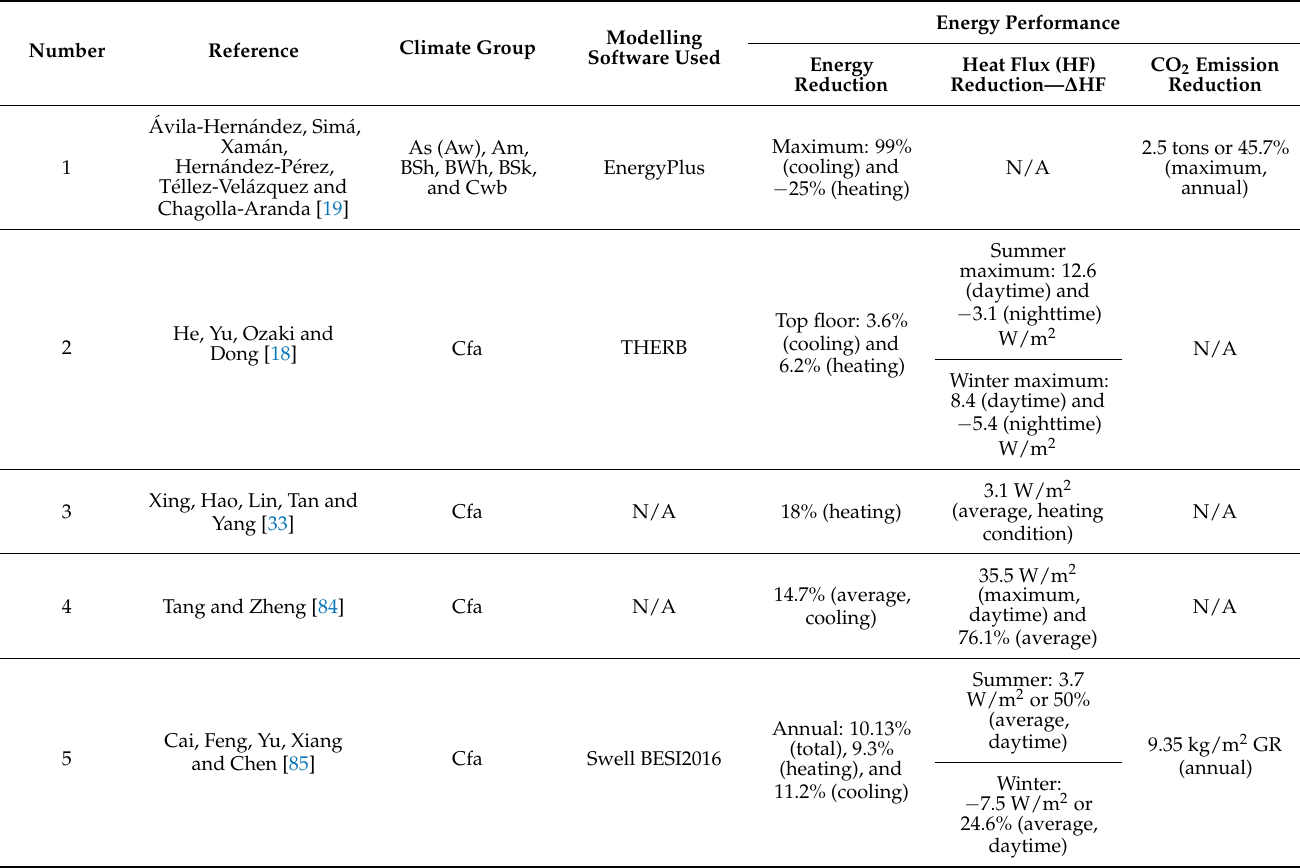
Table 3. Quantification of energy use reduction caused by green